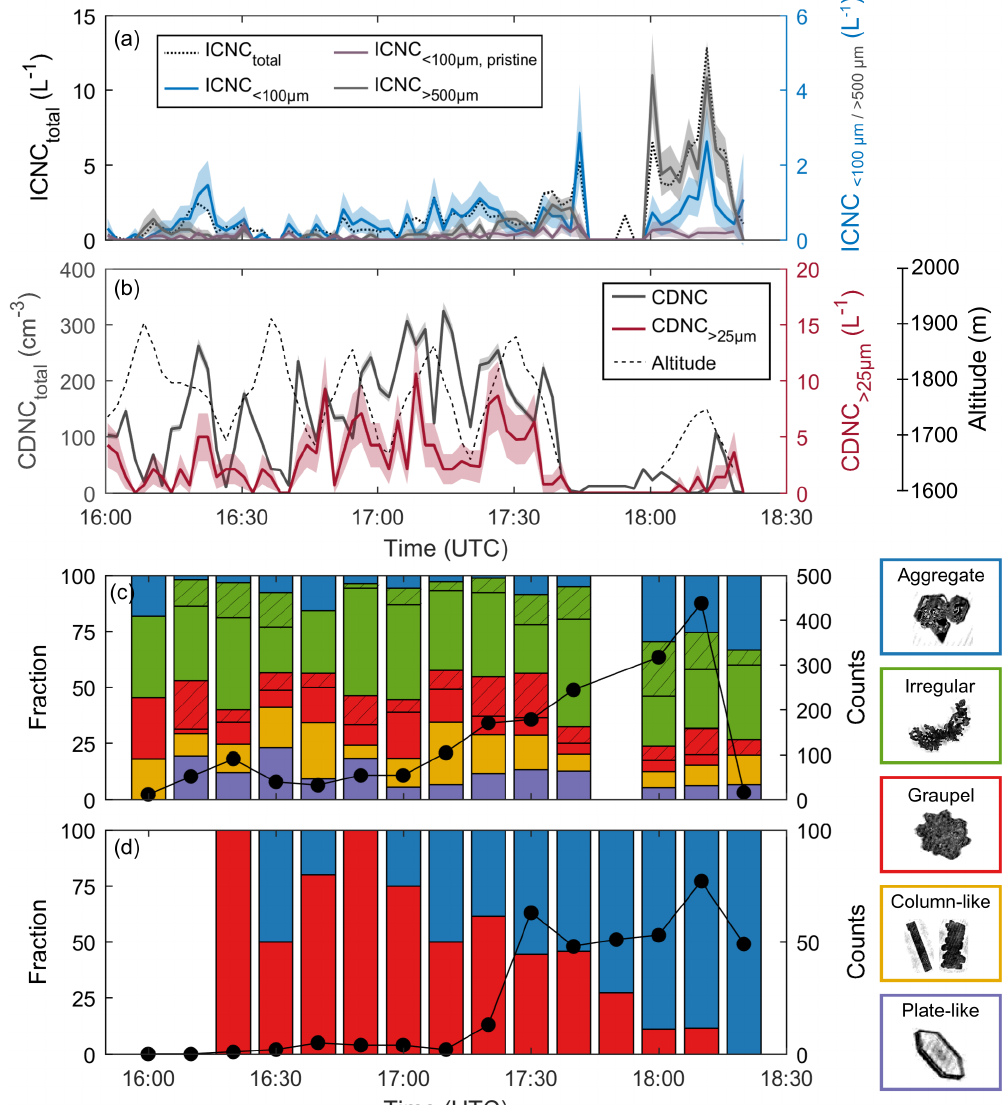
Figure 14. Time series of the ice (a) and liquid (b) cloud properties measured by the HoloBalloon platform. The left y axes in (a) and (b) show the total cloud particle concentrations ( a : ICNC, b : CDNC), whereas the other cloud properties are displayed on the right y axes. The shaded areas indicate the uncertainty of the concentrations. The dashed line in (b) shows the altitude of the balloon. The temporal evolution of the ice habit fraction is shown in (c) , HOLIMO, and (d) , MASC (see Sect. 2.2.1 for more information about the classification). The total counts during the 10min interval are indicated by the black dots. Example ice particles are shown on the right. Shaded areas in (c) indicate particles with a higher degree of